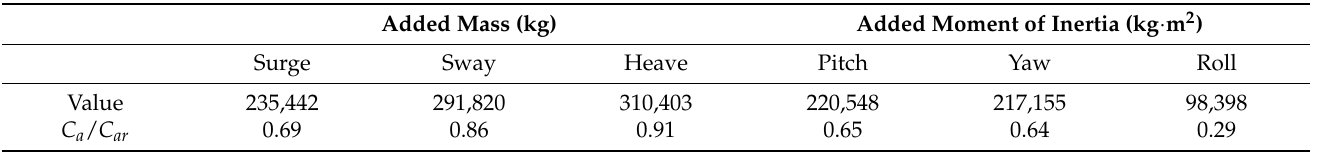
Table 2. C a for the six degrees of freedom (6DoF).